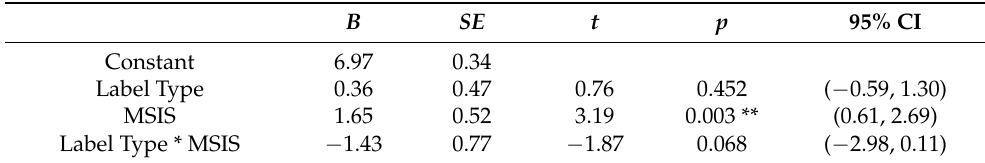
Table 4. Unstandardised regression coefficients for ‘refreshingness’ ratings ( N =